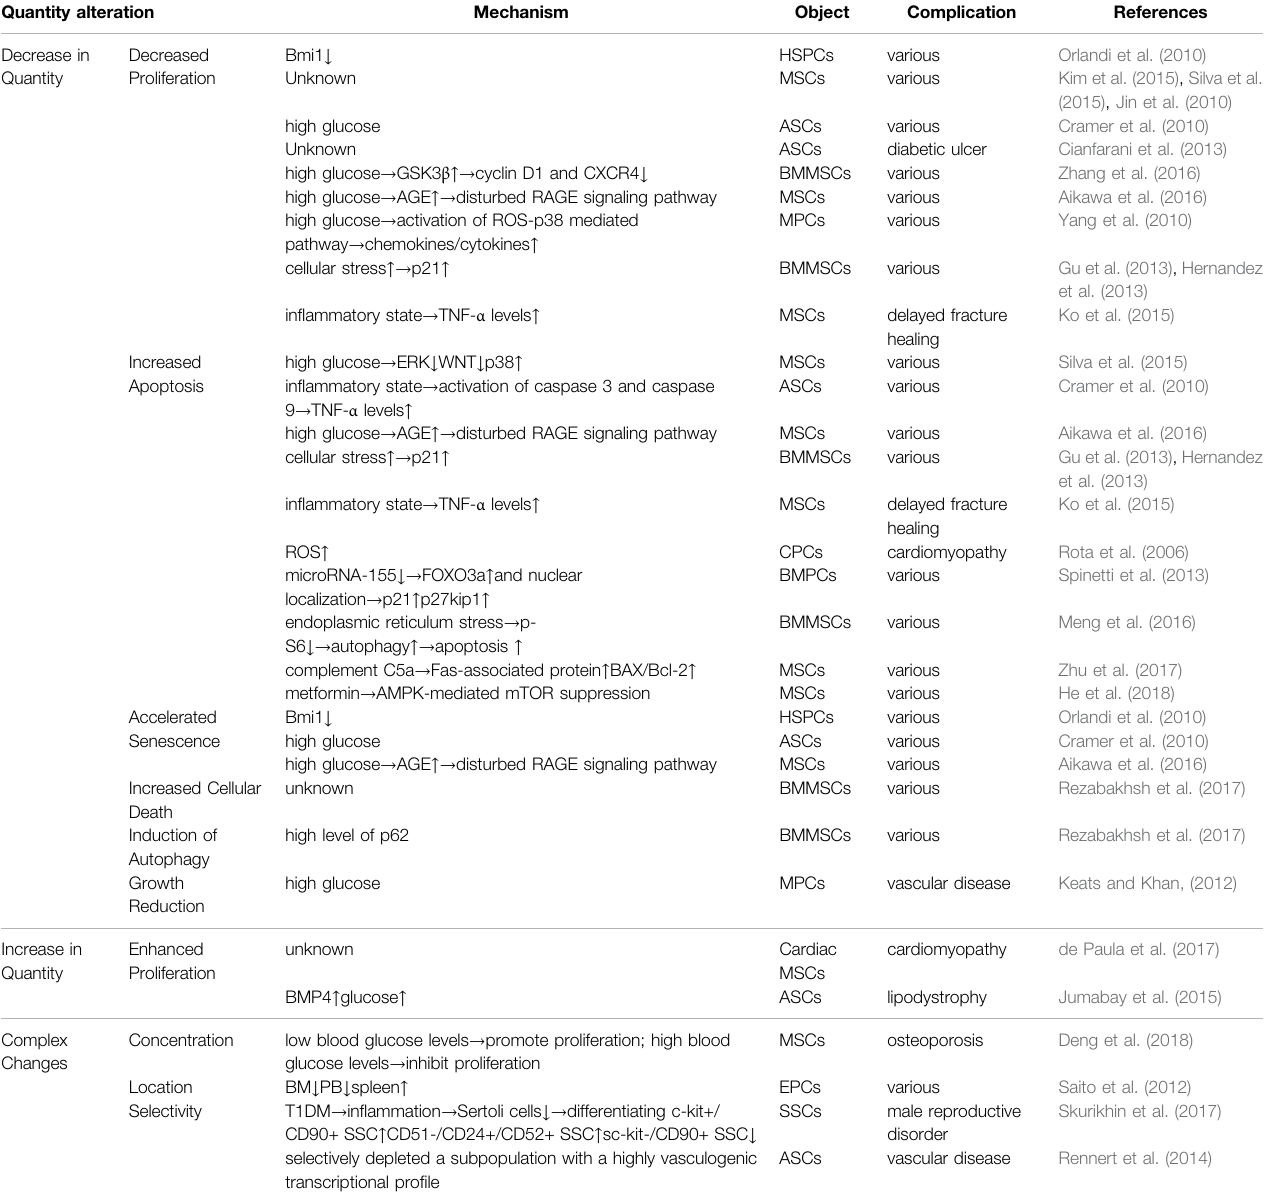
TABLE 2 | Summarizes the mechanisms, objects, complications and the corresponding references of stem cells quantity alteration in